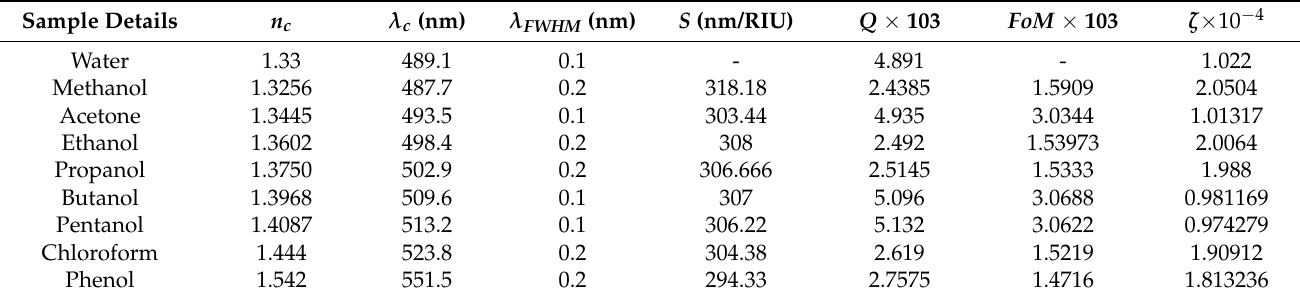
Table 4. Bio-alcohol sensor performance with d c = 165 nm corresponding to θ = 70 ◦